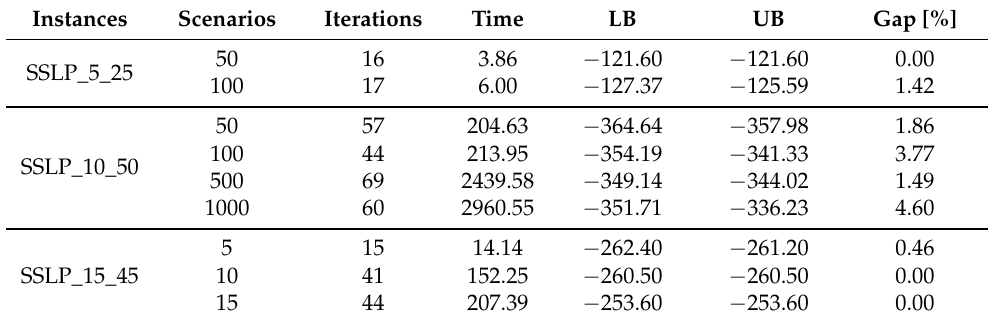
Table A4. Computational results for DSP on SSLP.